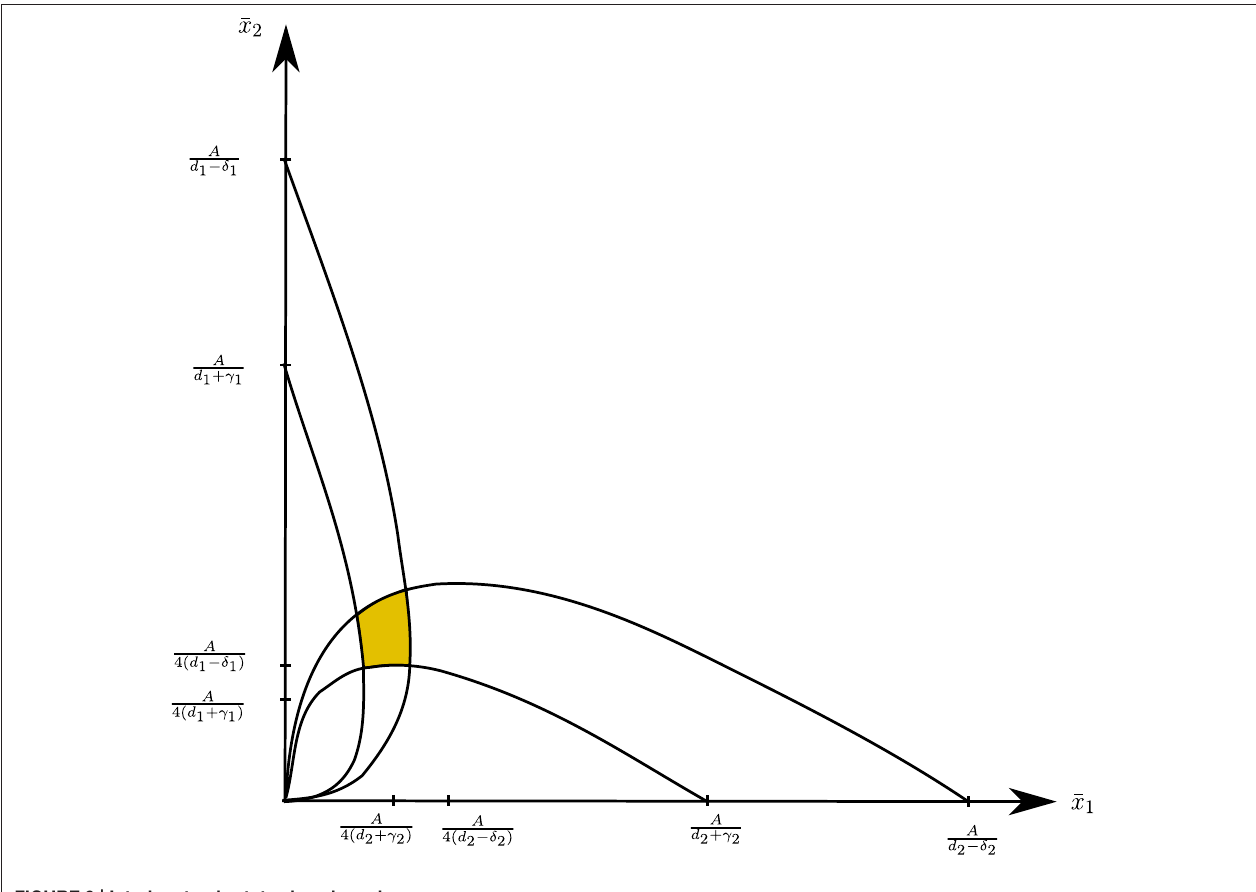
FIGURE 9 | Interior steady states in a